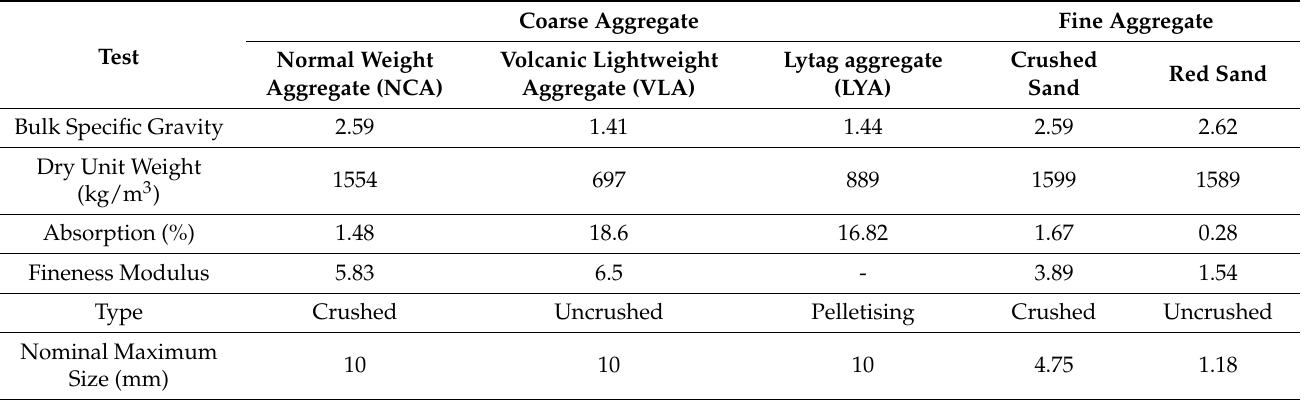
Figure 2. Grading curve of normal weight coarse (NCA) and volcanic lightweight coarse (VLA) aggregate.